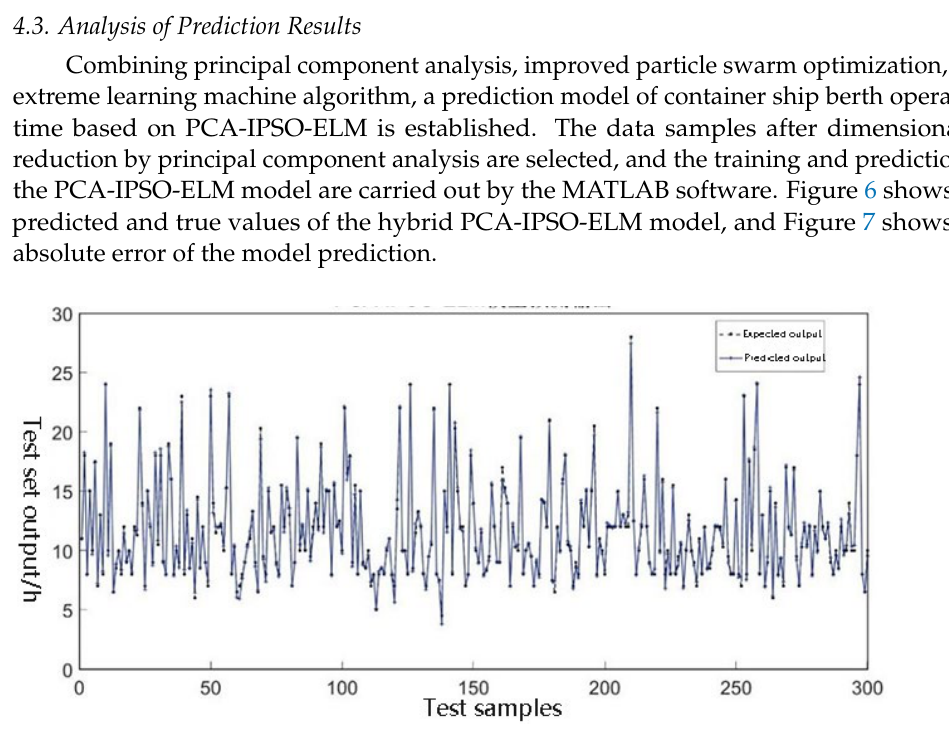
Figure 7. PCA-IPSO-ELM model prediction absolute error diagram. In Figure 6, the black dotted line indicates the expected output value, and the blue solid line indicates the predicted output of the model. The predicted trend is consistent with the actual container ship’s berth operation, and the fitting degree of the model is good. At the same time, it can be seen from Figure 7 that the absolute prediction error of the PCA-IPSO-ELM model is generally in a low floating range. It can be inferred that this model has good prediction performance in predicting the berth operation time of container ships. In order to further verify the effectiveness of the PCA-IPSO-ELM prediction model, the standard BP neural network model, ELM model, GA-BP neural network model, and the IPSO-ELM model are selected as comparison experiments. Among them, the excitation function of the hidden layer of the BP neural network is Sigmoid, the excitation function of the output layer is Purelin, the number of neurons in the hidden layer is 10, the maximum number of training is 500, the accuracy requirement is set to 0.0001, the learning rate is 0.01, the weights and thresholds of the network are initialized to a value between them, the chromosome coding length in GA is 168, the population size is set to 60, the evolution algebra is 30, and the crossover probability is 0. The BP, ELM, GA-BP, and IPSO-ELM models are programmed using the MATLAB platform to complete the training process of the models, and the test set is predicted and analyzed. The prediction results of the PCA-IPSO-ELM model proposed in this paper are compared with the other four models, and it is finds that the single BP neural network model has the worst prediction effect and the biggest error. Compared with the standard BP neural network, the GA-BP model improves the prediction accuracy, but the iteration speed is slow and the solution process takes a long time. The PCA-IPSO-ELM model